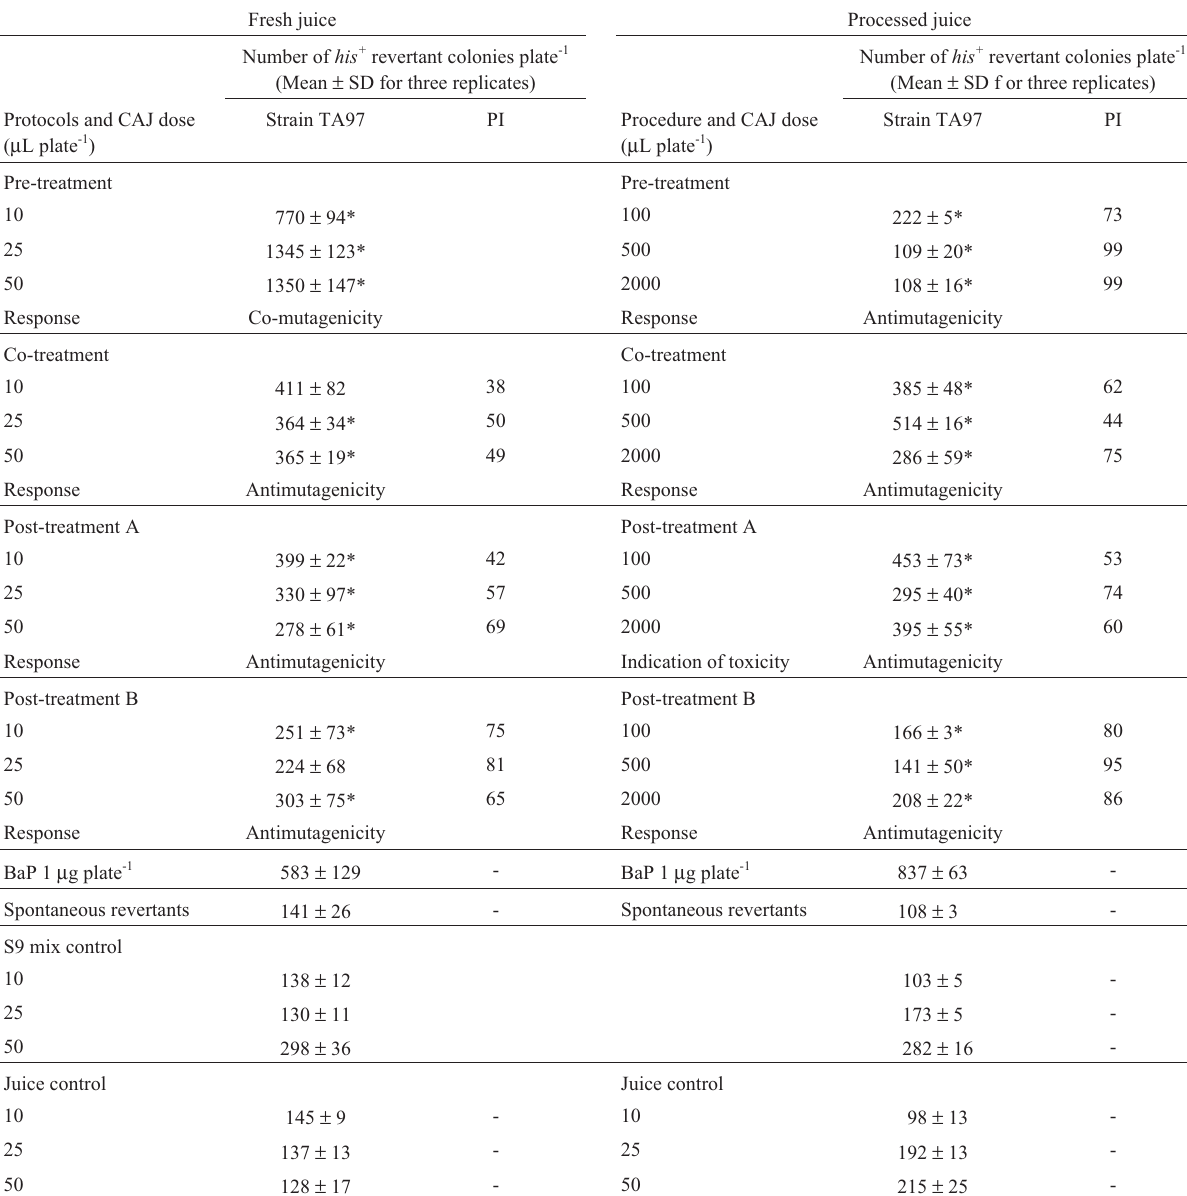
Table 3 - Effects of cashew apple juice (CAJ) against benzo[a]pyrene (BaP) using Salmonella typhimurium strain TA97a as indicator organism. Percent- ageinhibition(PI)calculatedasPI=[1-(B-A/B)]X100,whereArepresentsplatescontainingmutagensandBrepresentstheplatecontainingmutagens and juice (Melo-Cavalcante et al. , 2003) Antimutagenicity = PI ≥ 50%. Indication of toxicity when the number of revertant colonies < 70% compared to number of spontaneous revertants. Co-mutagenicity when there is a significant increase in mutagenicity as compared to positive control. The number of spontaneousrevertantswassubtractedfromallplates.Valuesaremeans ± standarddeviations(SD).ProtocolsforCAJtesting:pre-treatment,juice+bac- teriainfreshnutrientbrothfor4h,washbacteriaandaddmutagen ± S9mixfor20min,washbacteriaandplate;co-treatment,juice+mutagenfor20min + S9 mix for 20 min, add to the bacteria and plate, (method B) mutagen + S9 mix for 20 min, add juice and incubate for 20 min, add the bacteria and plate; post-treatment A, bacteria + mutagen + S9 mix for 20 min, wash bacteria, add the juice and plate; and post-treatment B, bacteria + mutagen + S9 mix for 20 min, wash and incubate with juice in fresh broth for 30 min wash bacteria and